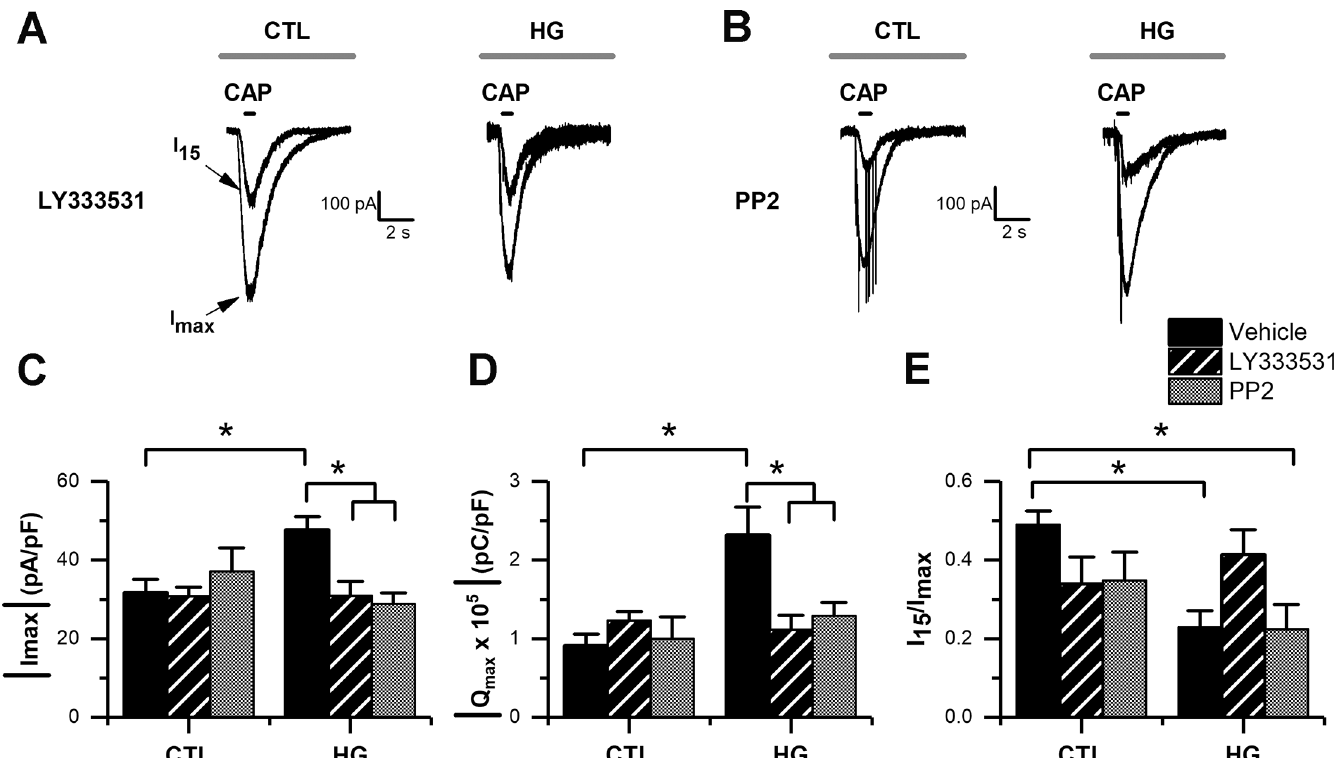
Fig 7. Potentiation of CAP-evoked currents was dependent on PKC and Src kinase activity. A, representative current traces of CAP-evoked currents obtained from cultured DRG neurons during whole-cell voltage-clamp recording (holding potential set at -60 mV), in control (CTL) and high glucose (HG) conditions in the presence of LY333531 and PP2. B-D, bar graphs summarize maximal current (I max ) density (B), maximal current charge (Q max ; C), and current rundown calculated as the ratio I 15 /I max (D). Bars show treatment conditions examined: vehicle (DMSO 1 μ l/ml, CTL and HG n = 10), LY333531 (CTL, n = 11; HG, n = 9), and PP2 (CTL, n = 5; HG, n = 5). All data are represented as mean ± SEM. The absolute current density and charge were used in B and C for simplicity. Statistical analysis by two-way ANOVA followed by Sidak’s post-hoc test. (cid:3) , p <